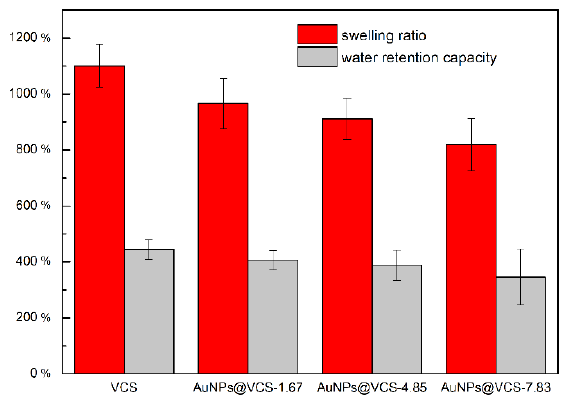
Figure 8. Swelling ratio and water retention capacity of VCS and AuNPs@VCS.